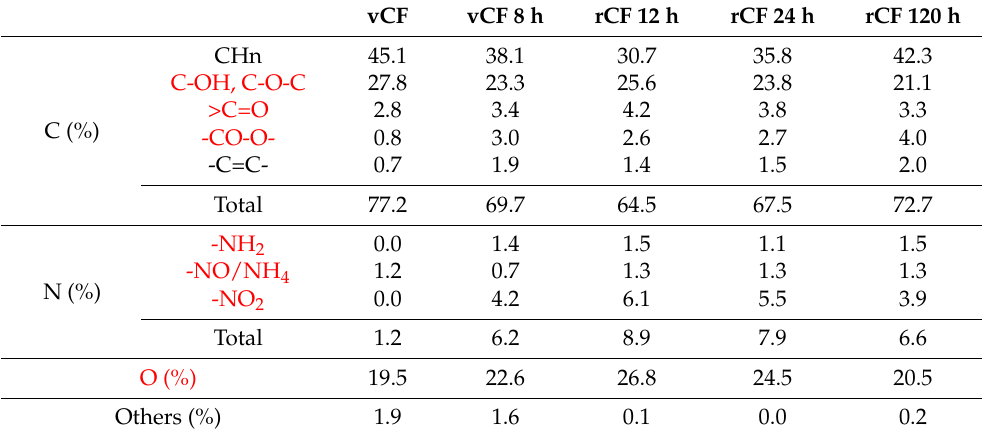
Table 1. Atomic concentrations of vCF and rCF measured by XPS, and polar functional groups are shown in red